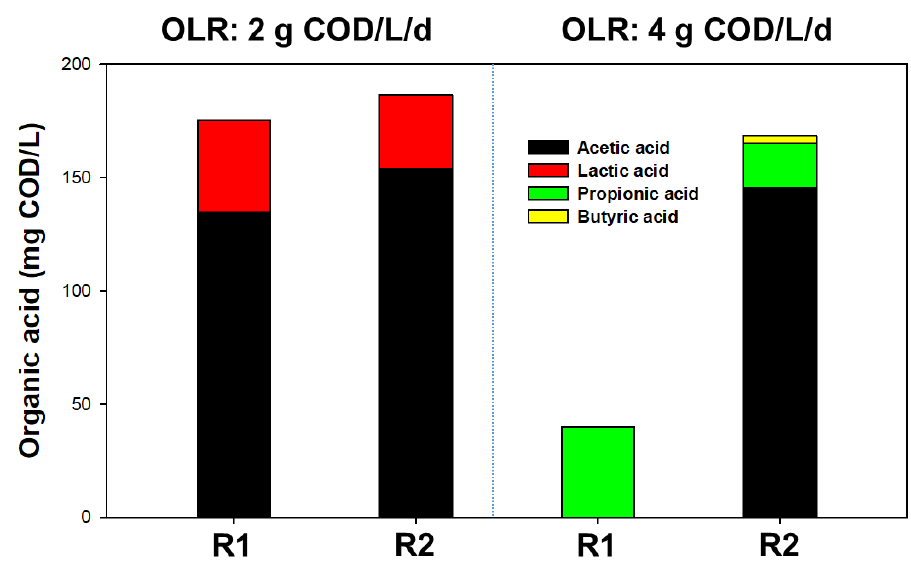
Figure 2. The performance of the organic acid at the steady-state of the reactor with polymeric hollow-fiber media (PHM) and carbon-nanotube hollow-fiber media (CHM).